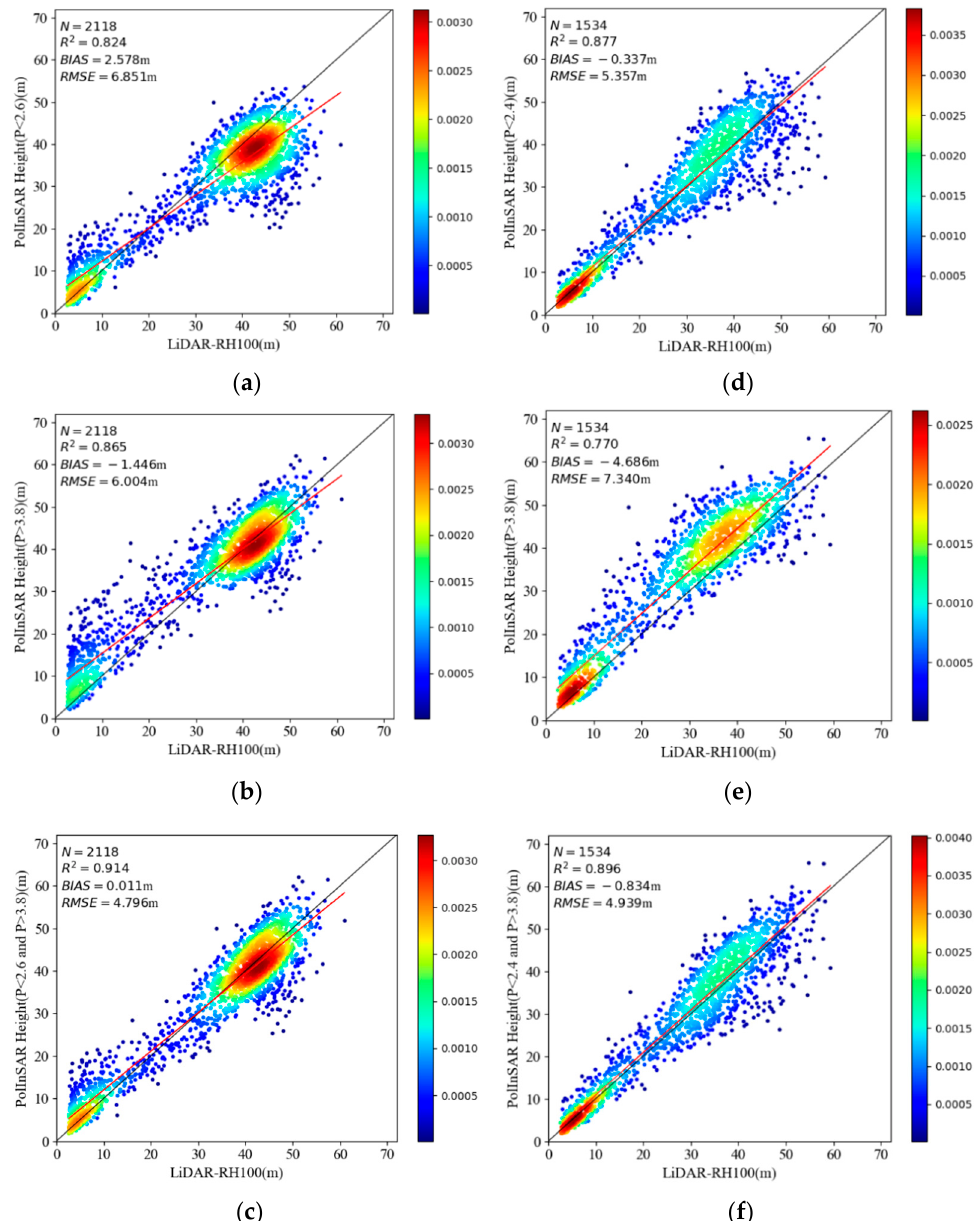
Figure 11. Plots showing validation of the results corrected according to the P threshold in the ( a – c ) Lope test area and ( d – f ) Pongara test